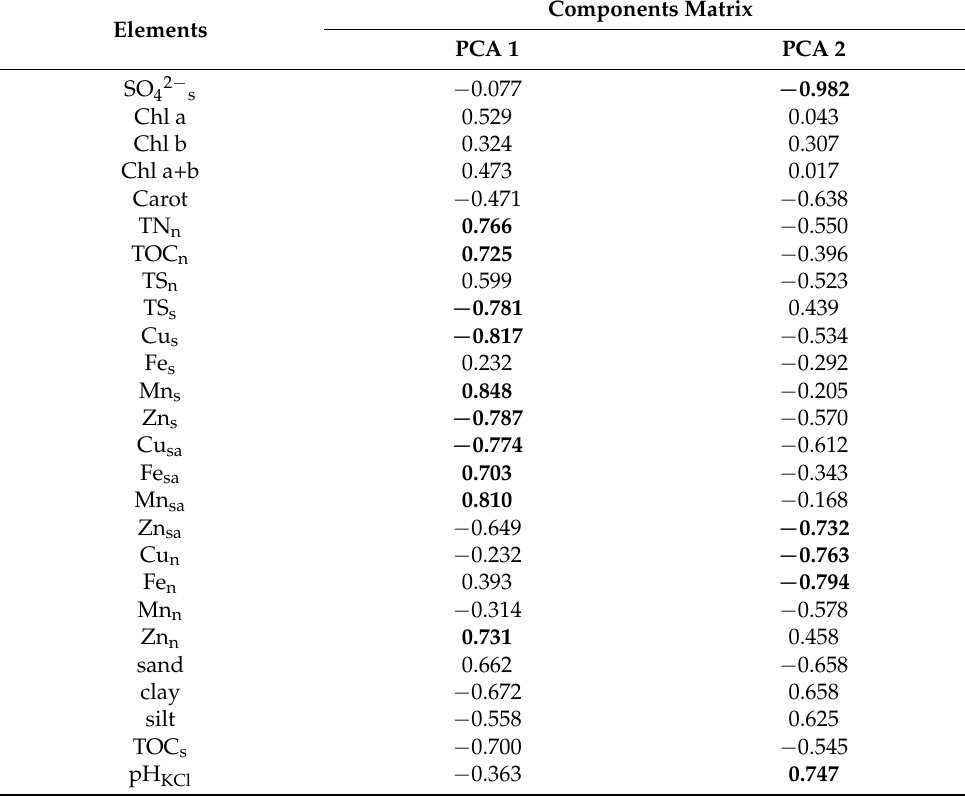
Table 6. Values of the two extracted factor loadings for 26 elements ( n =